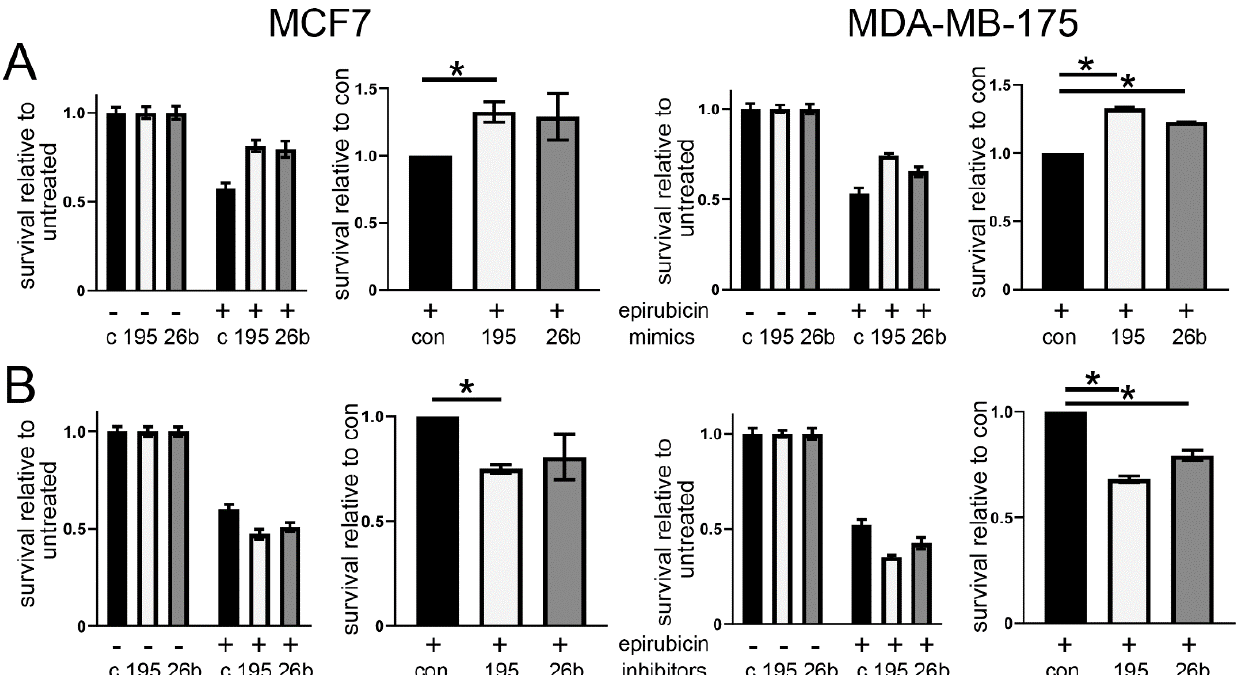
Figure 2. MiR-195 and miR-26b modify the chemoresponse of estrogen receptor positive breast cancer cells. The MCF7 or MDA-MB-175 cells were transfected with miRNA mimics or mimic controls ( A ) or miRNA inhibitors or inhibitor controls ( B ) (195, 26b or con (c)). 48 h after transfection, cells were treated with epirubicin (“+”; MCF7 30 nM; MDA-MB-175 600 nM) or with vehicle control (“ − ”). 24 h later, cells were replated at low density in fresh medium in order to determine relative survival in colony forming assays. Data are presented in two separate plots: left, relative to untreated (vehicle control), with 1 biological repeat showing error bars representing SD of 2 replicate wells; right, relative to mimic or inhibitor controls, representative of means of 3 (MCF7) or 2 (MDA-MB-175) biological replicates, with error bars representing the SEM of biological replicates. Differences between targeted mimic/inhibitor and controls were tested using paired 1-tailed t tests; * indicates p < 0.05.